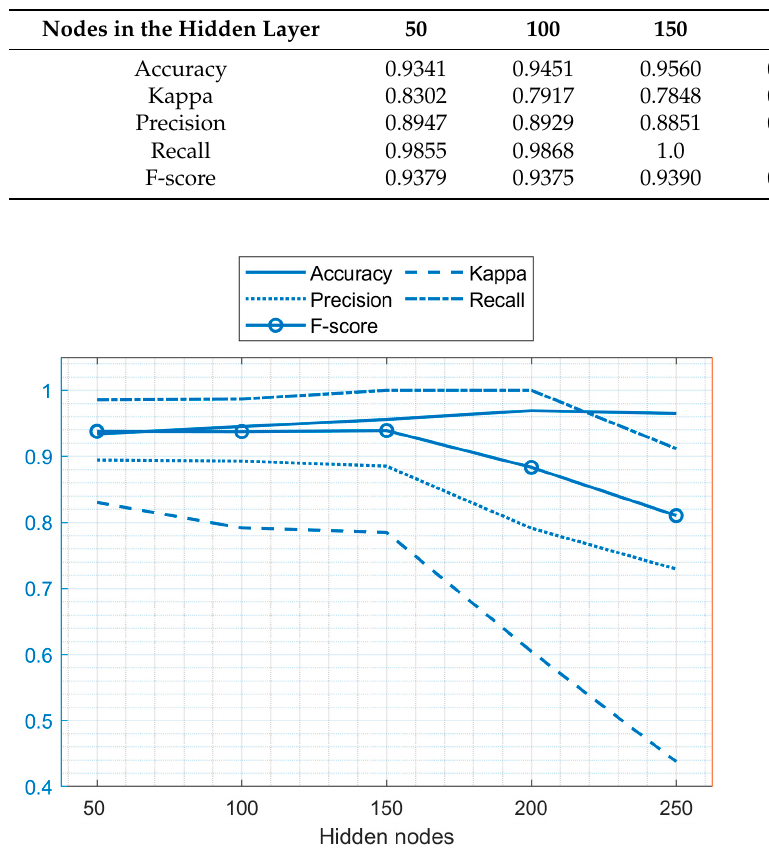
Figure 4. Graphical representation of the ELM performance (standalone environment).